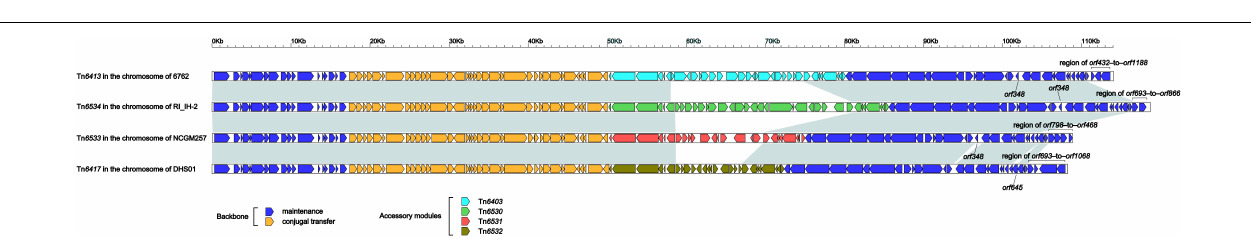
of IRi, 5’-CS, VR1 [GCA: gcu104 – aacA1 – catB3q :IS pa62